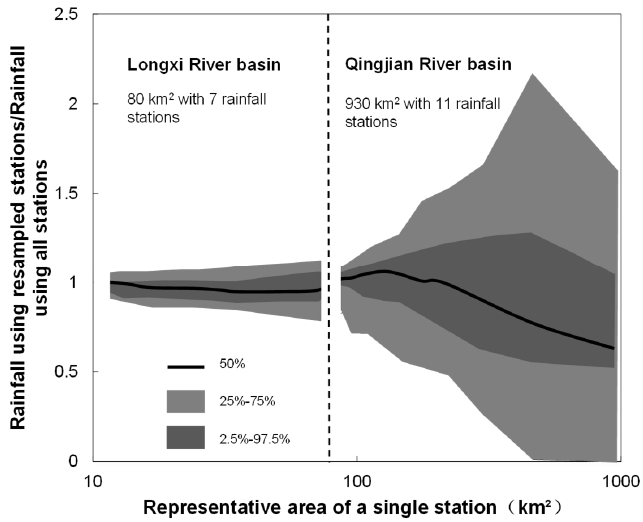
Figure 8. The non-dimensional uncertainty range of the average basin rainfall over the representative area of a single station.